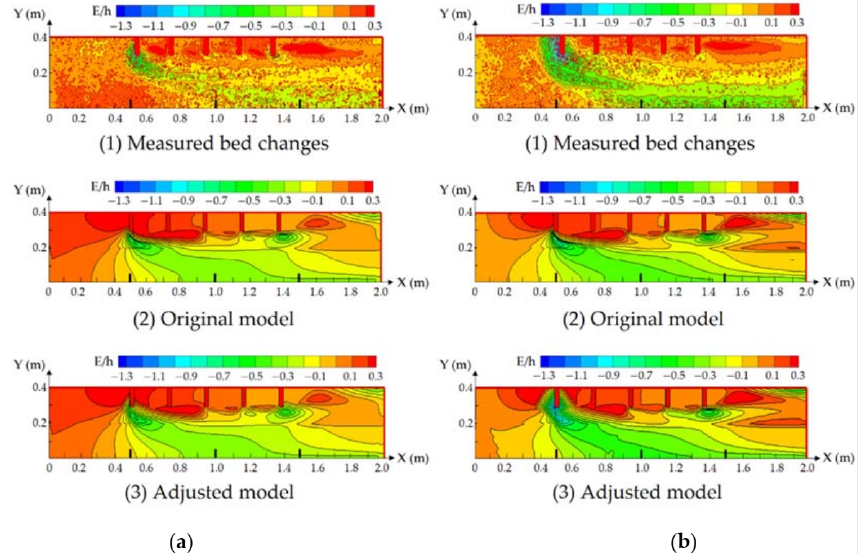
Figure 14. Overview of the simulated non-dimensional bed changes around multiple spur dikes when considering the angle of repose and adjusted bed geometry: ( a ) case G4a and ( b ) case G5a.